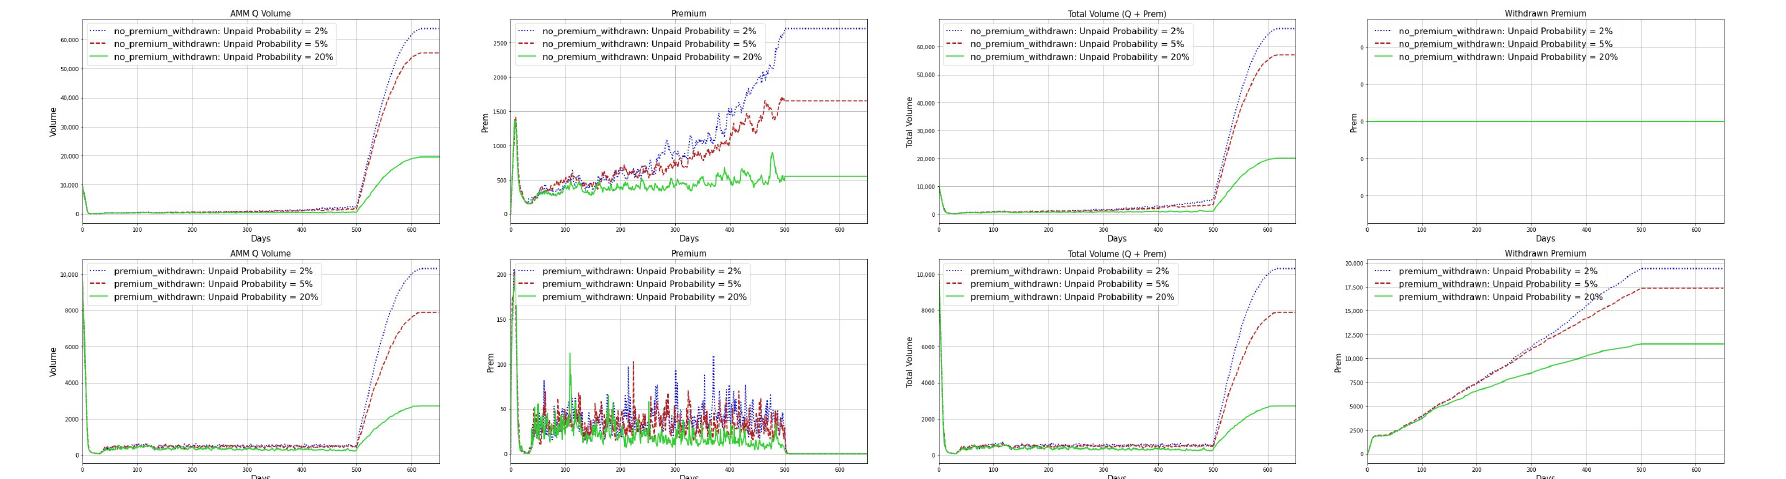
Figure A4. rkAMM Curves from simulation of scenario 2 and 1 day of withdrawal